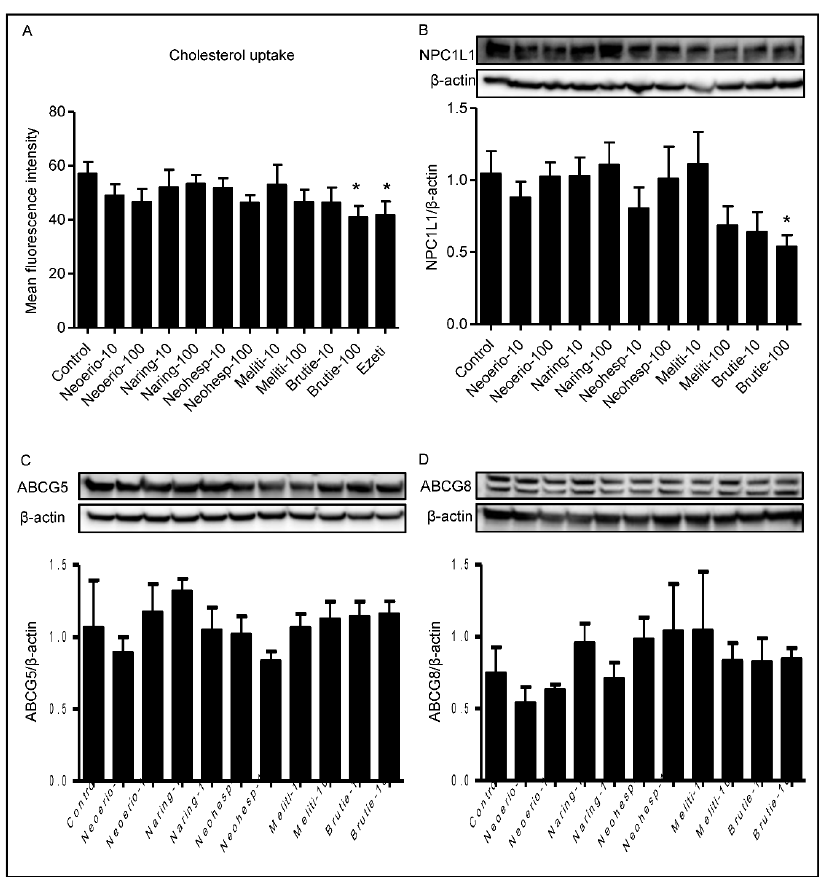
Figure 6. Effect of BFE principal components on cholesterol uptake ( A ) and cholesterol transport protein expression in Caco-2 cells. Cells were treated with BFE principal components (10 and 100 μM) for 24 h. ( B – D ),NPC1L1, ABCG5 and ABCG8 protein expression was detected by western blot analysis and quantified by densitometric analysis. The results are presented as mean ± SE.*: p < 0.05 compared with control group.